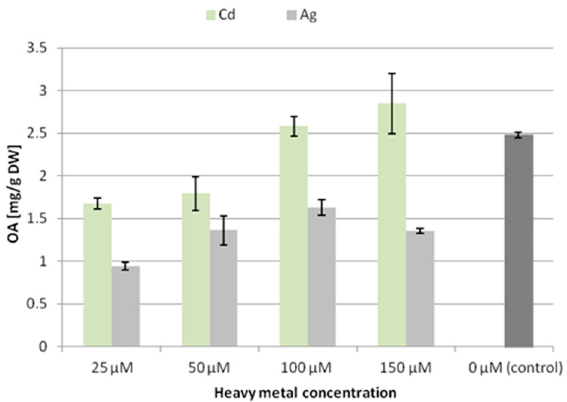
Figure 2. The content of oleanolic acid in hairy root tissue (CC16 line) after elicitation with silver and cadmium ions. OA—oleanolic acid.